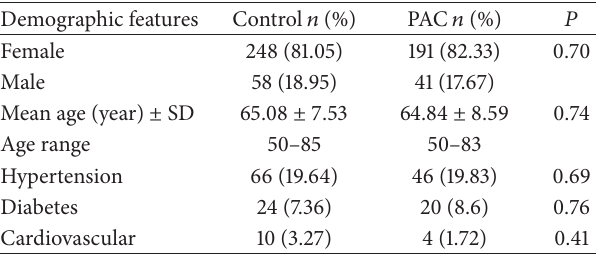
Table 1: Demographics of study